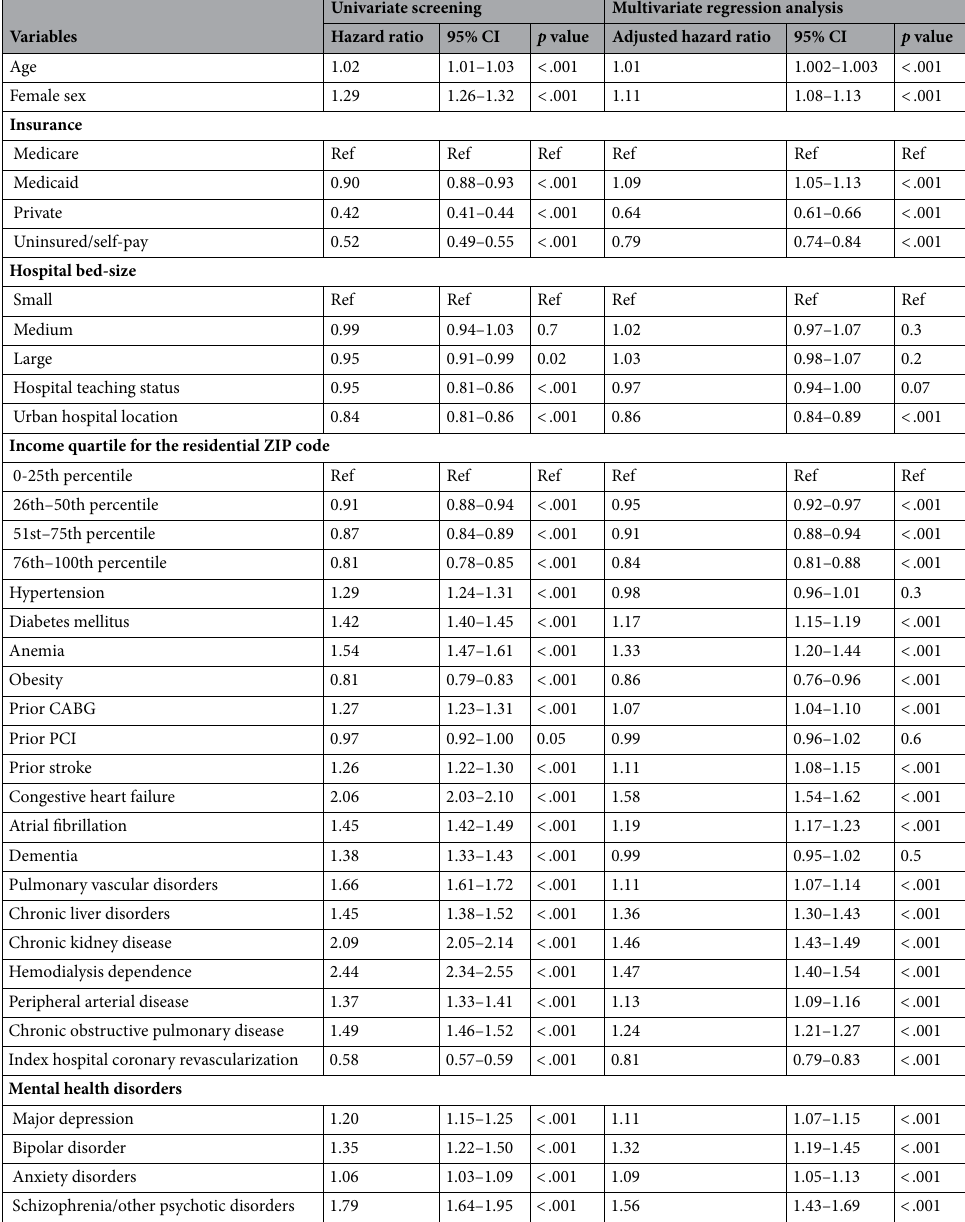
Table 2. Predictors of readmission after acute MI. CABG coronary artery bypass grafting, PCI percutaneous coronary